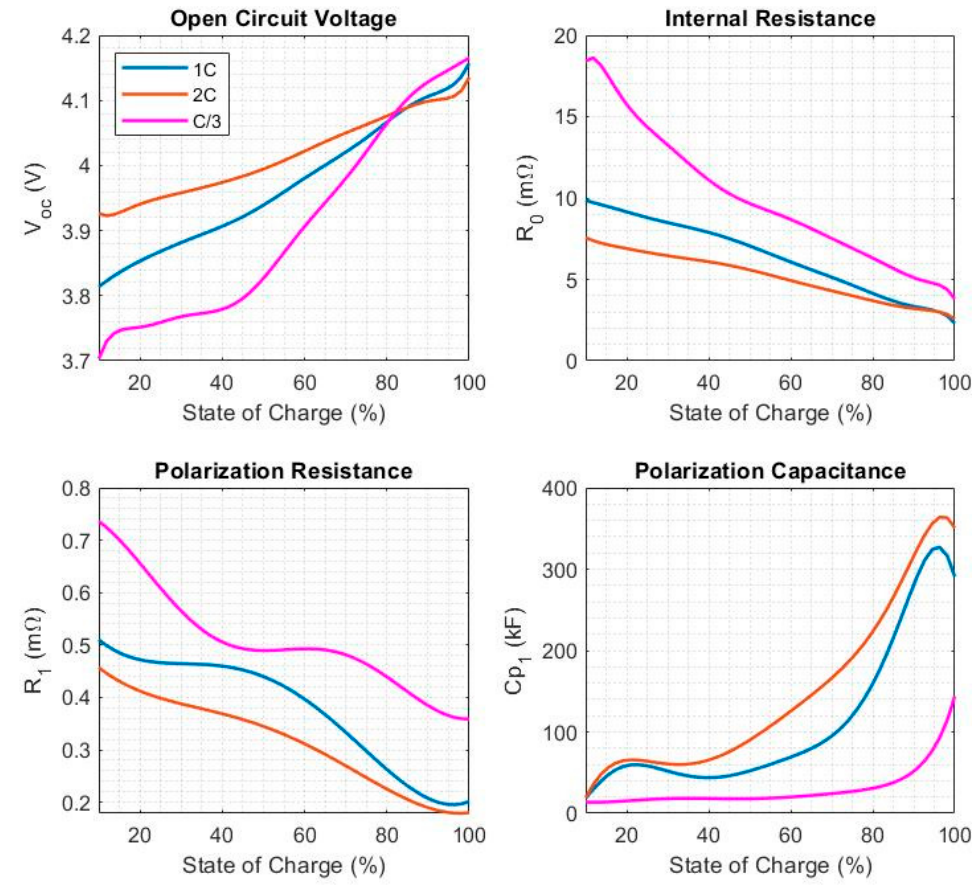
Figure 5. Estimated parameters—First order Thévenin model.